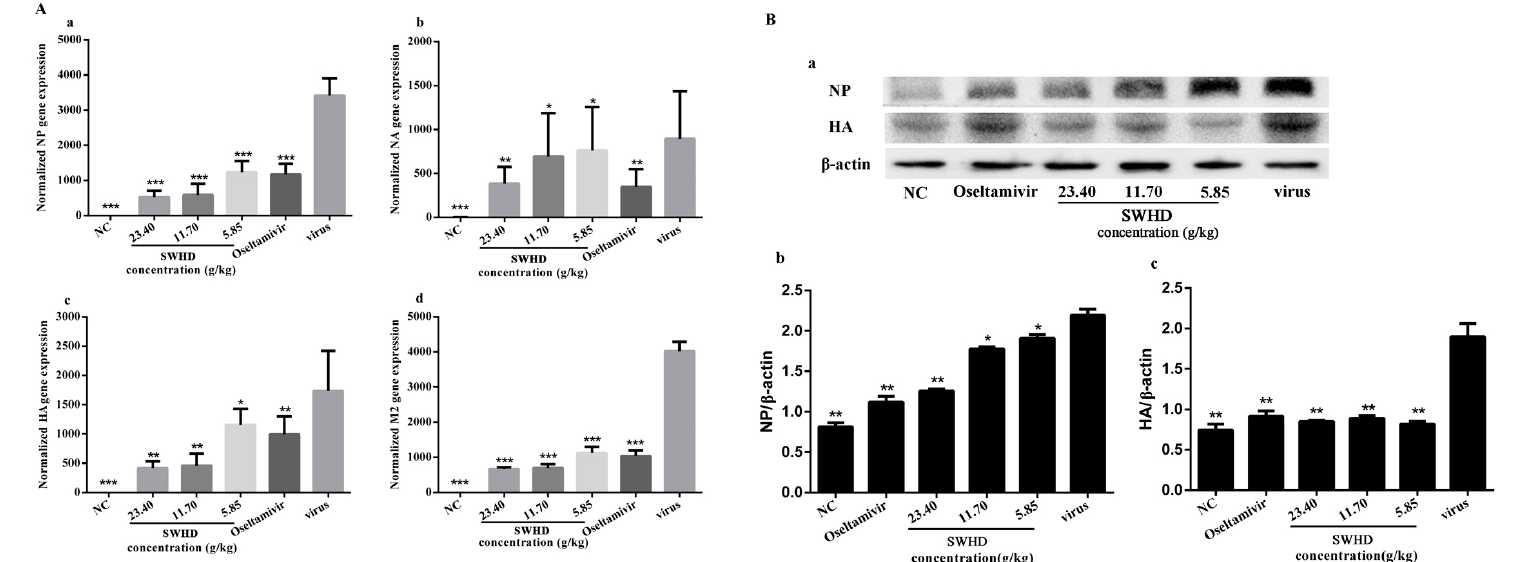
Figure 6. ( A ) The quantification of viral mRNA expression of the four genes NP, M2, HA and NA in vivo by the SWHD extract on lethally IFV-infected mice. ( a ) the mRNA expression of the NP; ( b ) the mRNA expression of the NA; ( c ) the mRNA expression of the HA; ( d ) the mRNA expression of the M2. ( B ) The expression of the NP and HA proteins of the lungs were detected by Western blot analysis. All concentrations of the SWHD and oseltamivir could significantly inhibit the expression of the two proteins compared to the viral control. The values are presented as the means ± S.D. of three individual experiments. * p < 0.05; ** p < 0.01; *** p < 0.001, when compared to the viral control.